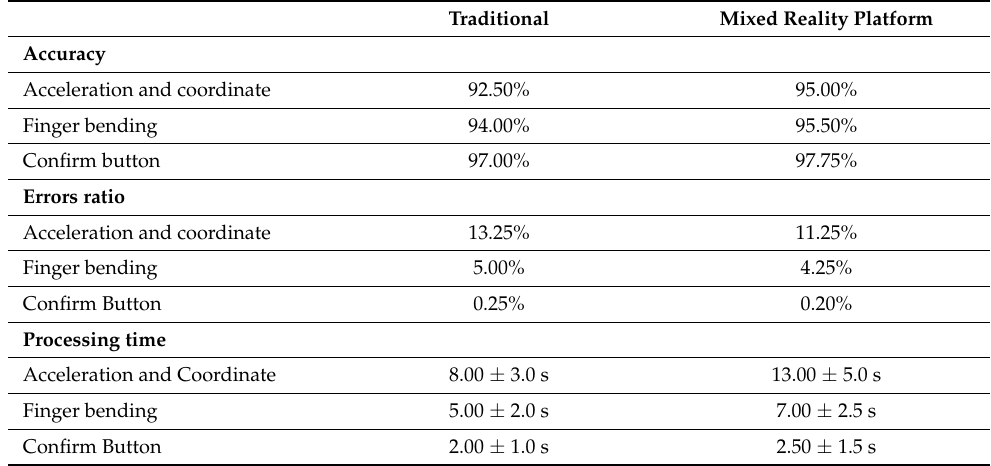
Table 12. Performance